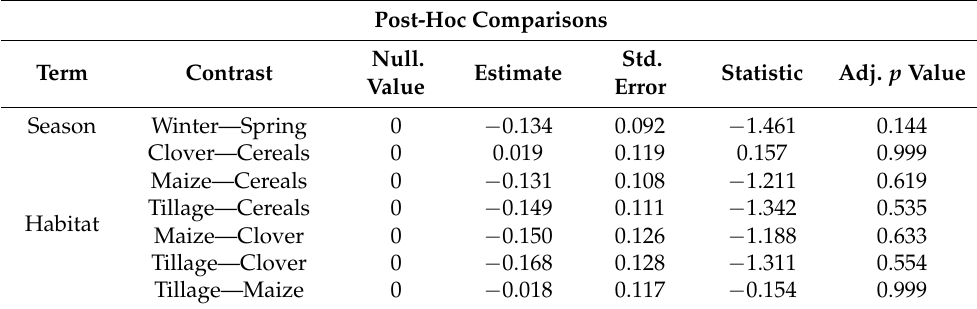
Table 4. Tukey all-pairs comparisons for Shannon entropy of the topsoil seed